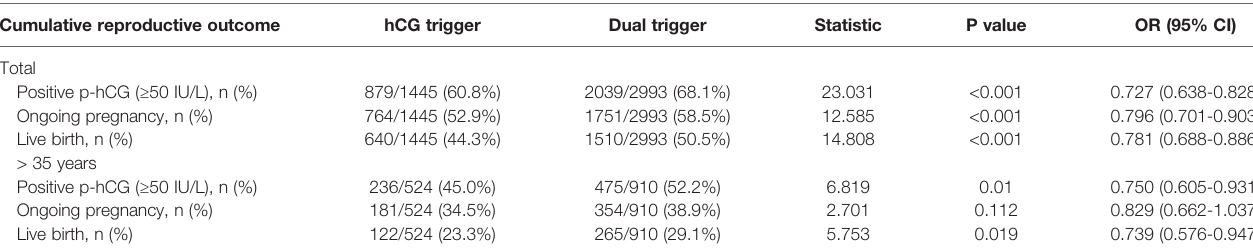
TABLE 3 | Cumulative reproductive outcome of one complete cycle of fresh and frozen – thawed embryo transfer until the fi rst live birth in women. Cumulative reproductive outcome